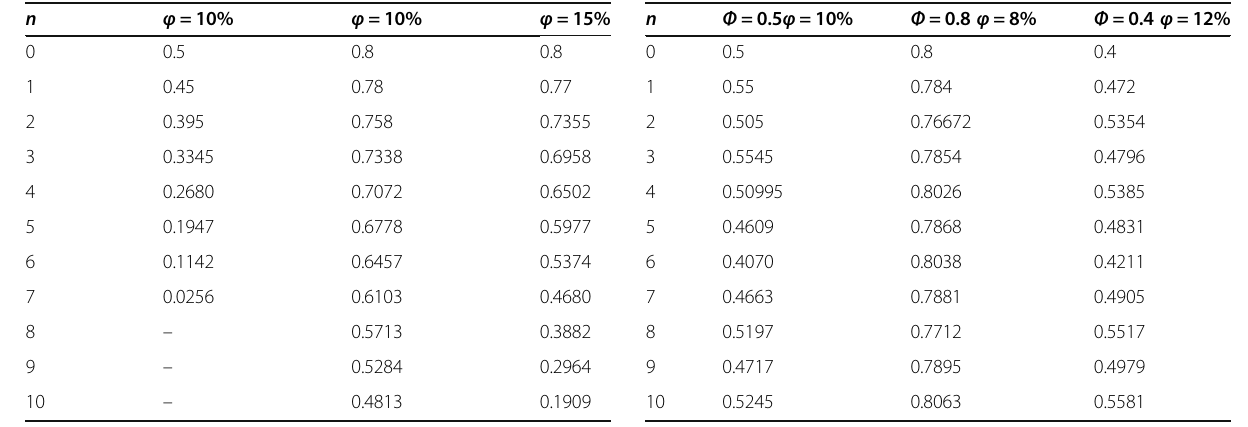
Table 5 Change of node 2 trust value in Case 2